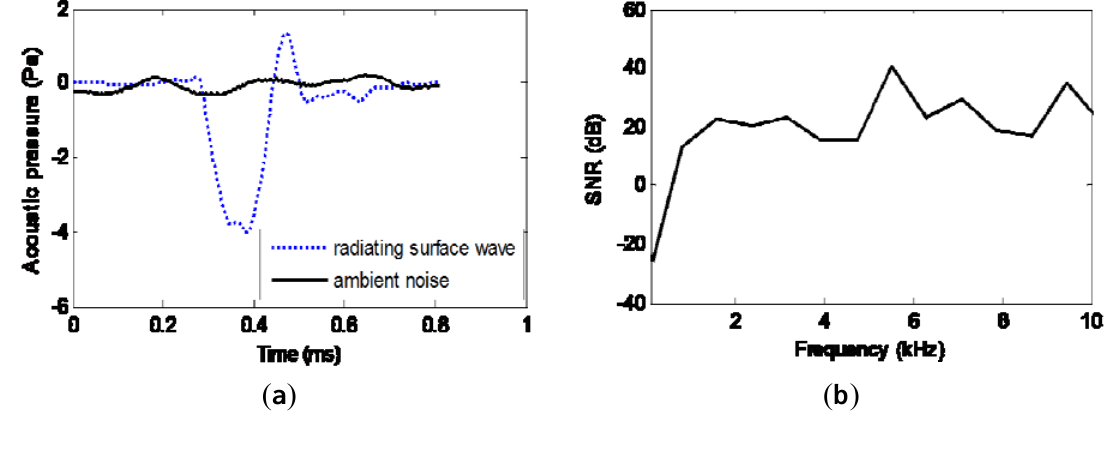
Figure 7. Ambient noise. ( a ) Comparison of extracted radiating surface wave and ambient noise. ( b ) Signal to noise